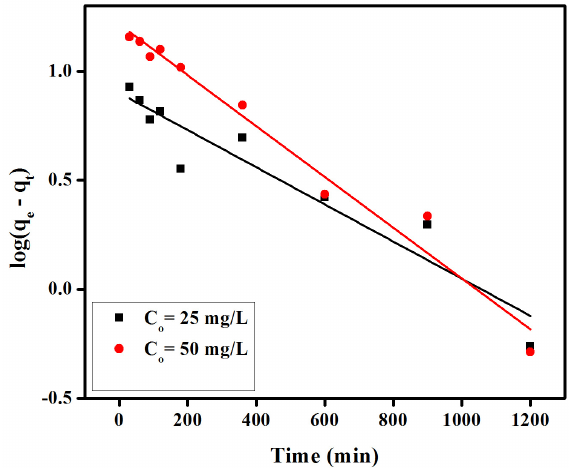
Figure 6. Pseudo-first-order Kinetics for adsorption of congo red on anion exchange membrane